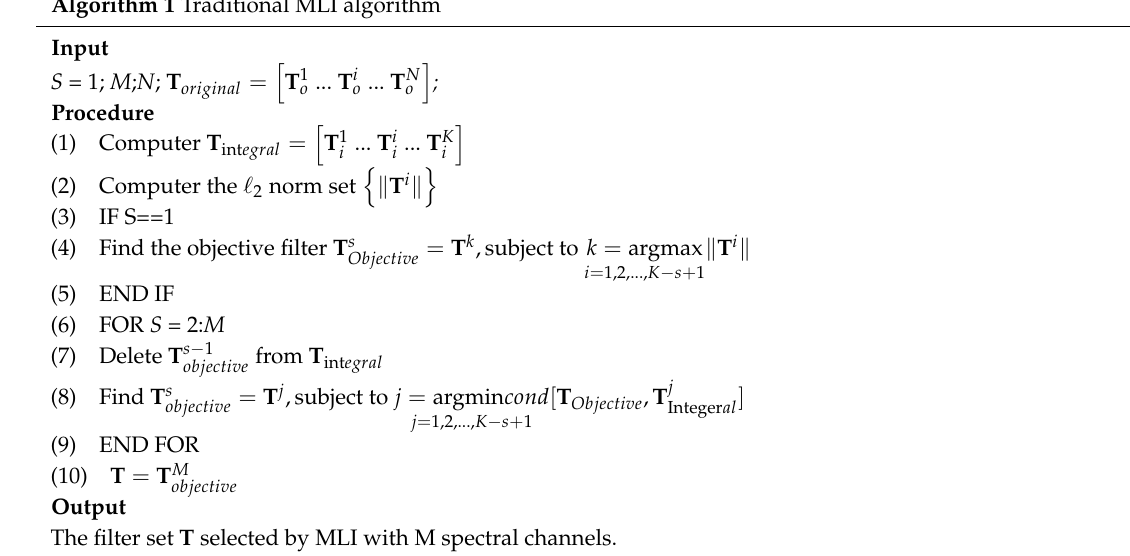
Algorithm 1 Traditional MLI